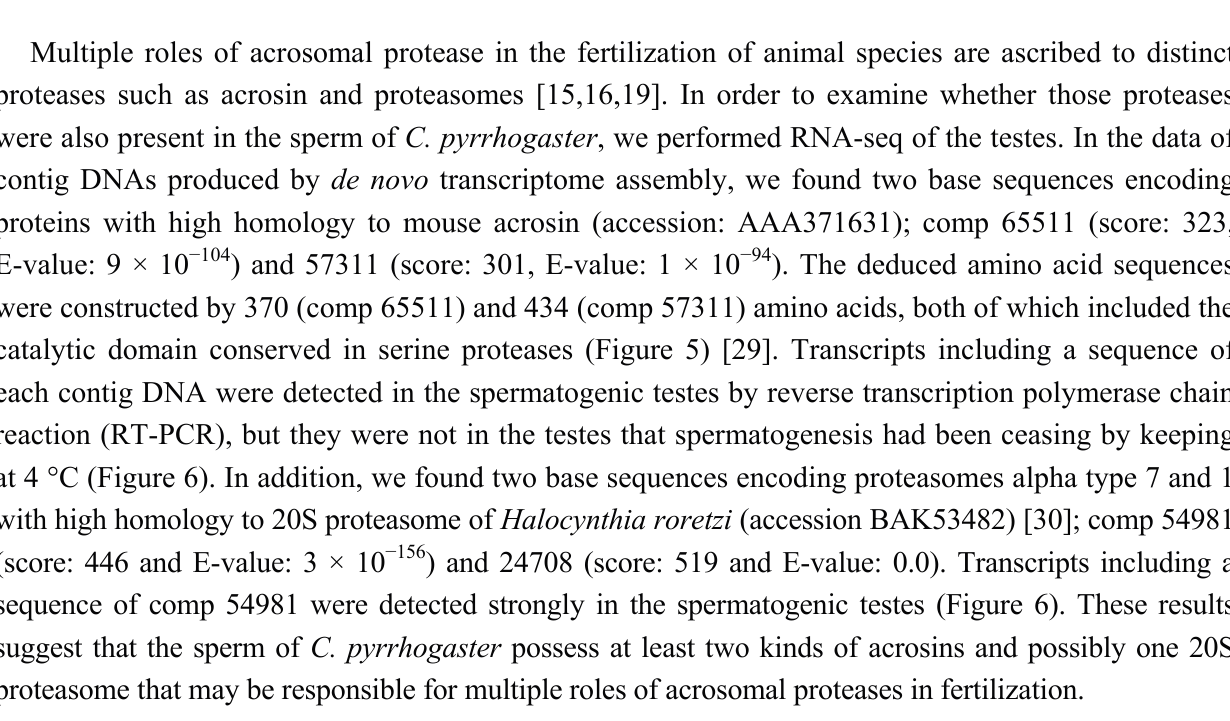
Figure 5. Sequence alignment of amino acid in catalytic domain of acrosins. Catalytic domains of mouse acrosin and acrosin-related protein of Xenopus tropicalis ( X. t. ) were obtained from NCBI gene database (NIH, Bethesda, MD, USA). Deduced amino acid sequences of comp 65511 and 57311 [31] were aligned on CLC workbench platform. Underlines were conserved regions of serine proteases for their proteolytic activity. Asterisks indicate strongly conserved amino acid residues in the catalytic